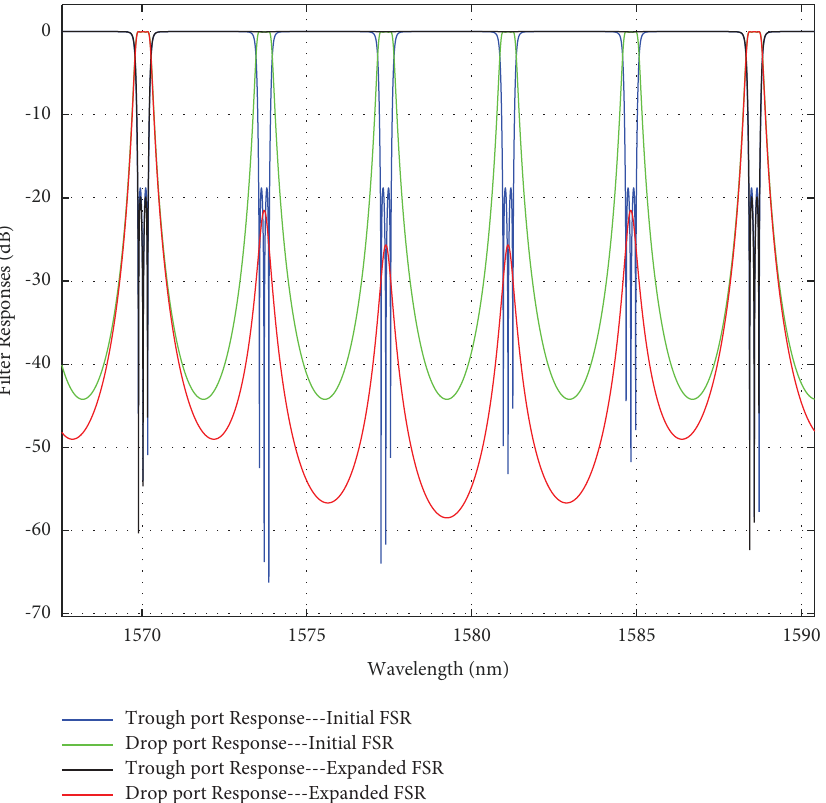
Figure 3: Filter response with an expanded FSR (Vernier efect) from 3.7nm to 18.5nm. Tis avoids the potential interference of neighboring DWDM channels on the full-FSR